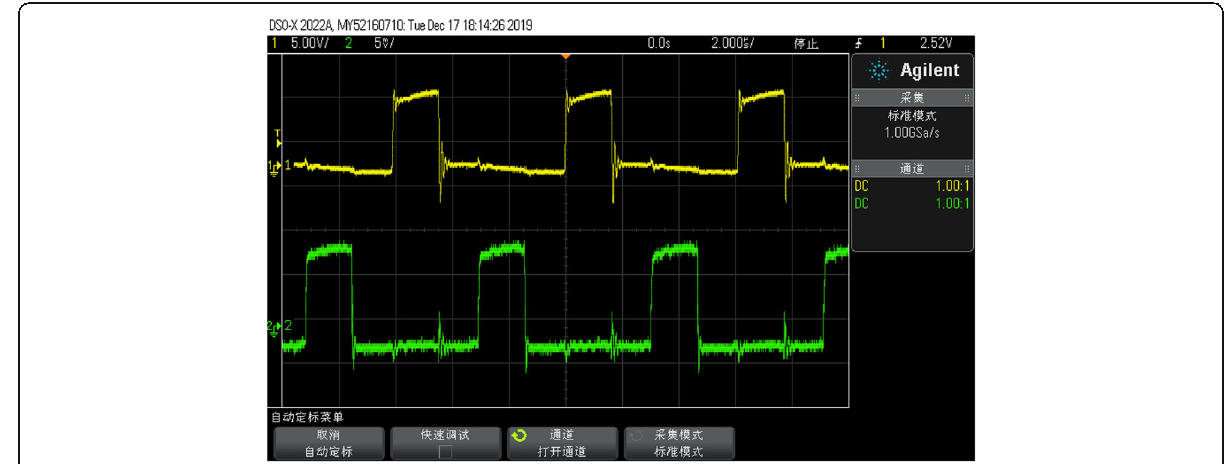
Fig. 15 Driving voltage waveform of MOS transistor